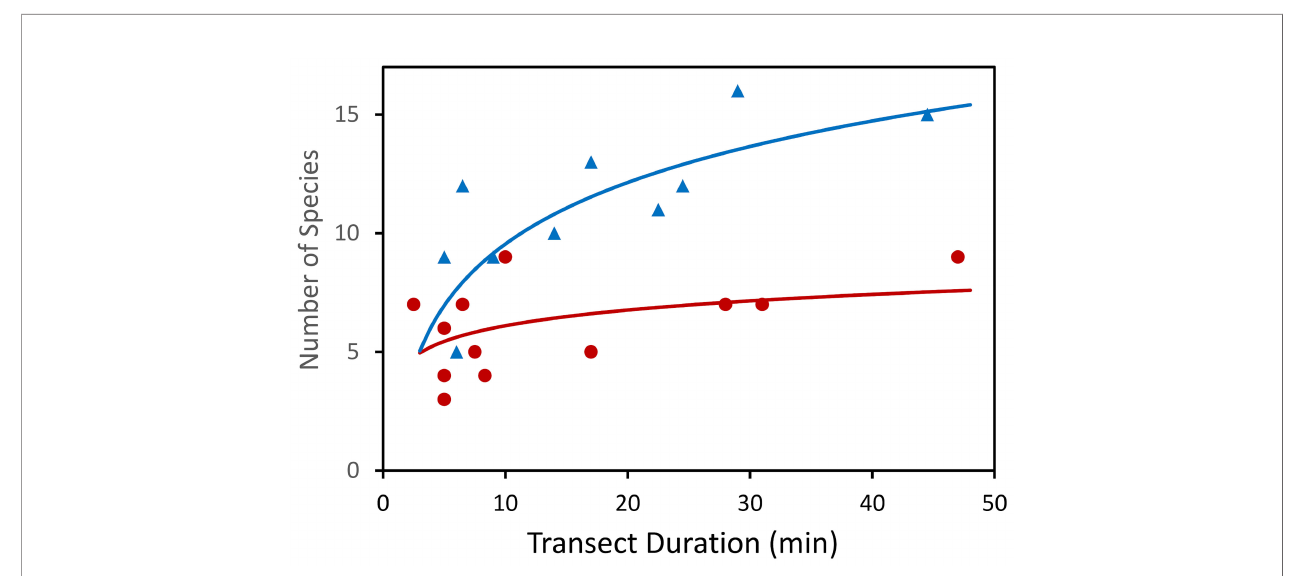
FIGURE 11 | Number of species observed during video transects across hard and soft substrates of the Charlie Gibbs Fracture Zone. Circles dark red – soft sediment. Triangles blue – hard rock. (After Gebruk and Krylova,